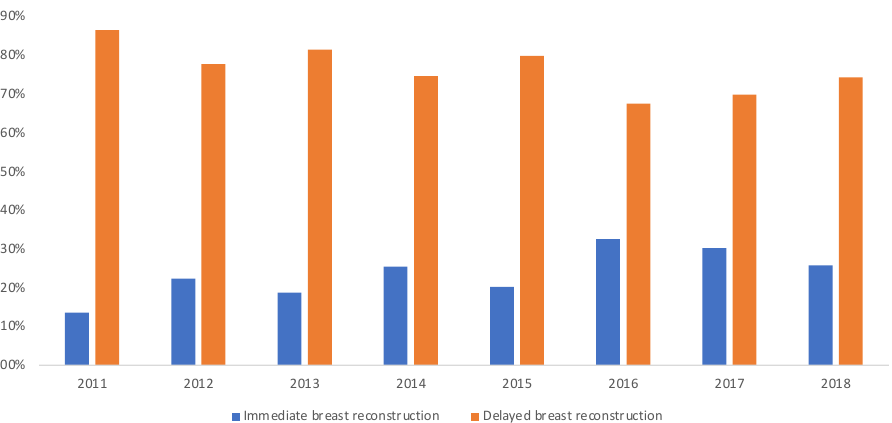
Figure 1. Increasing trend of immediate breast reconstruction performed between 2011–2018, pooled across all 22 centers ( p < 0.001 between years and type of reconstruction, immediate vs. delayed breast